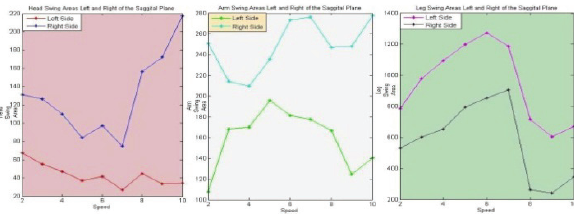
Fig. 9. Variation of features with speed for a single person using convex hull area.